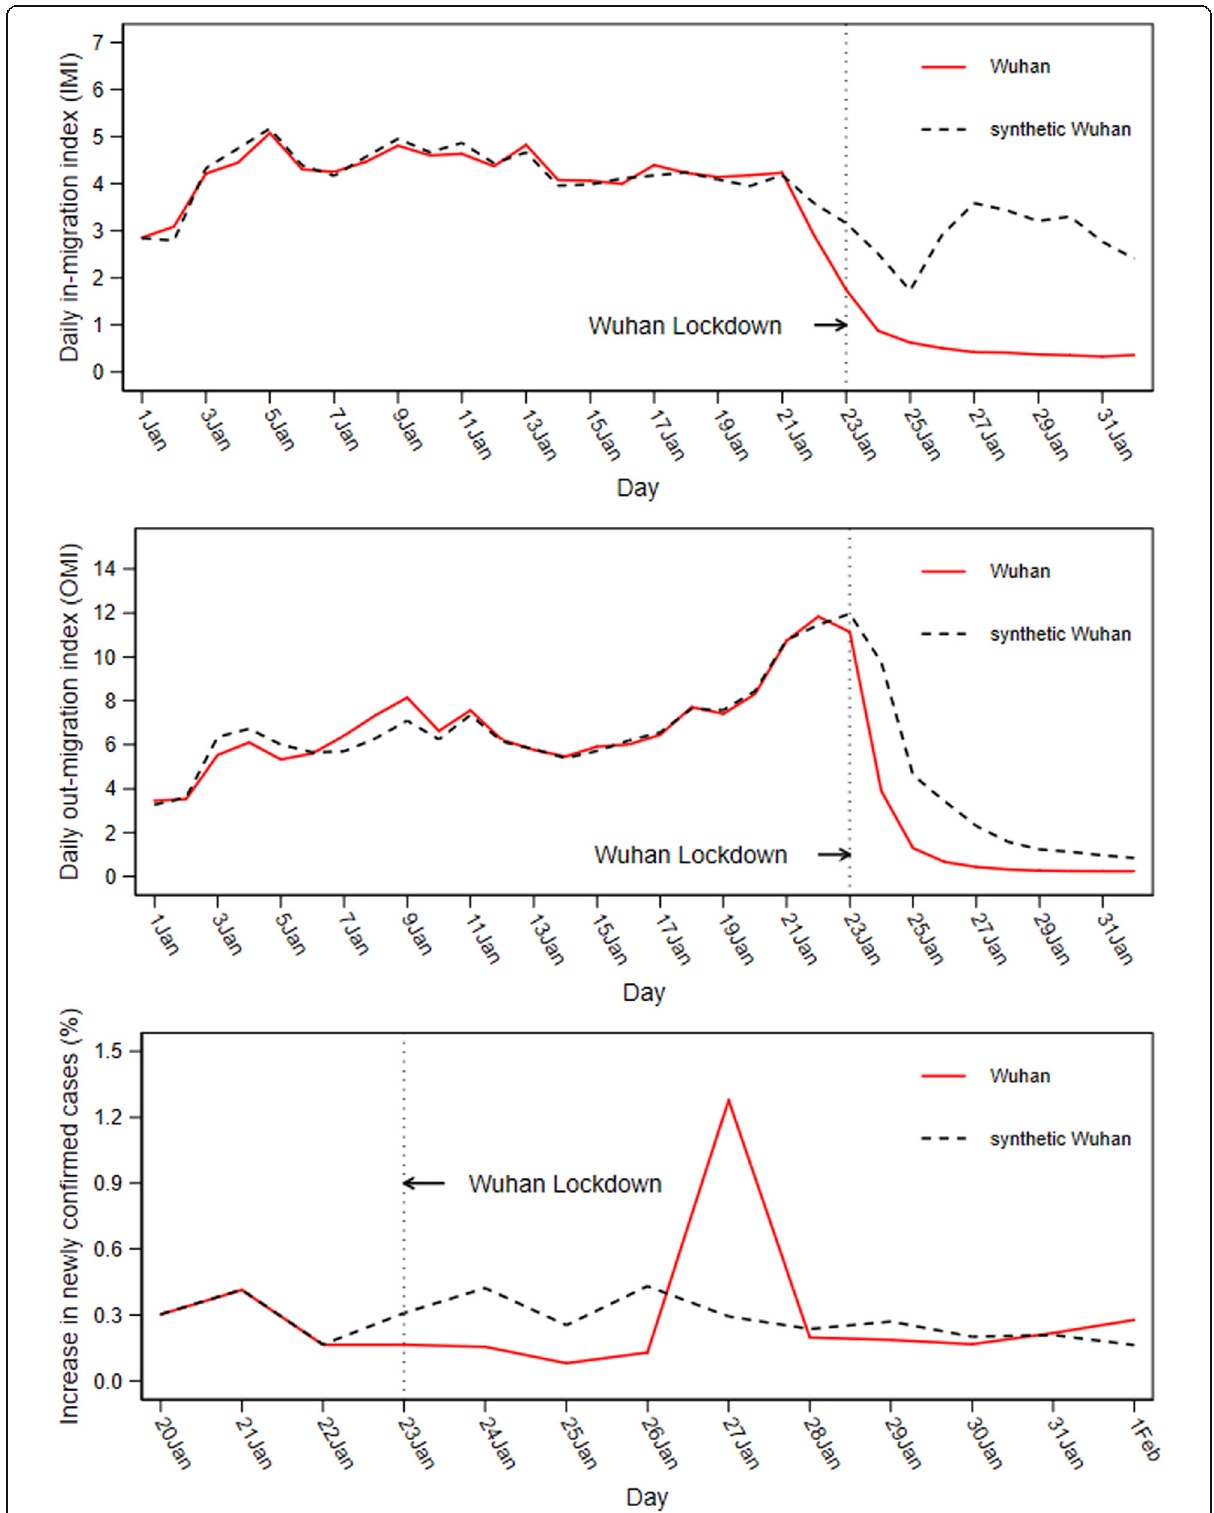
Fig. 2 Trends in IMI , OMI , and NewGrowth : Wuhan vs. synthetic